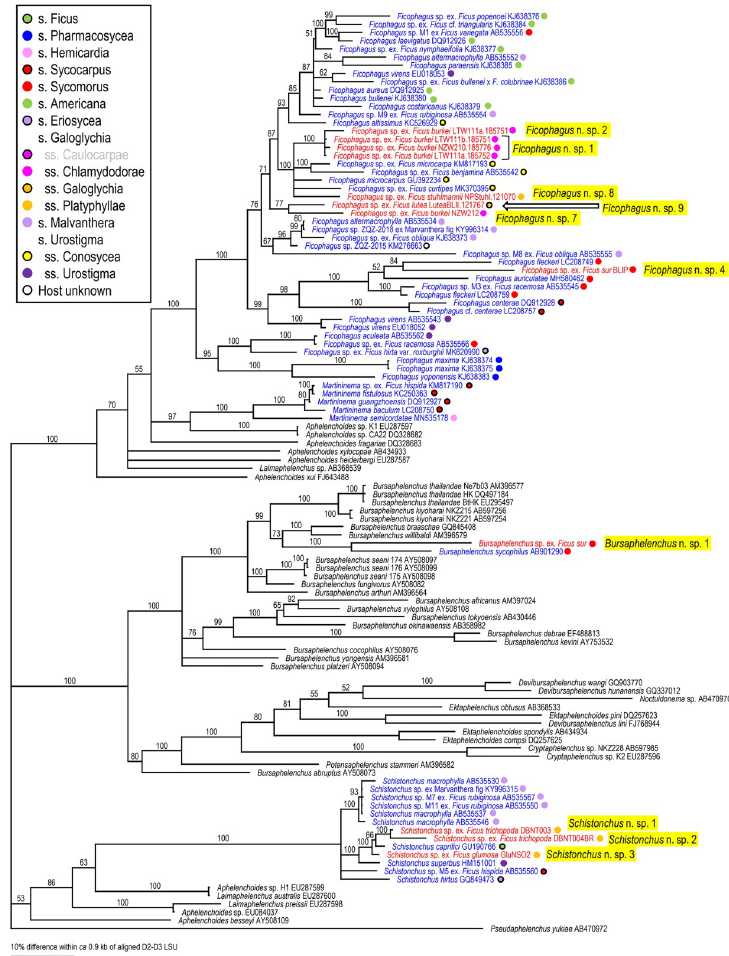
Fig 3. Phylogenetic status of fig-associated species within the family Aphelenchoididae inferred from D2-D3 LSU under GTR + G + I model. The parameters are: AIC = 55193.907, lnL = -27357.223, freqA = 0.24, freqC = 0.19, freqG = 0.30, freqT = 0.27, R(a) = 0.45, R(b) = 2.61, R(c) = 0.92, R(d) = 0.64, R(e) = 3.31, R(f) = 1.00, Pinva = 0.11, Shape = 0.86. Posterior probability values exceeding 50% are given on appropriate clades. Fig-associated nematode species obtained in the present study and previous studies are written in red and blue, respectively. Section or subsection of host fig species are coded with color dots.